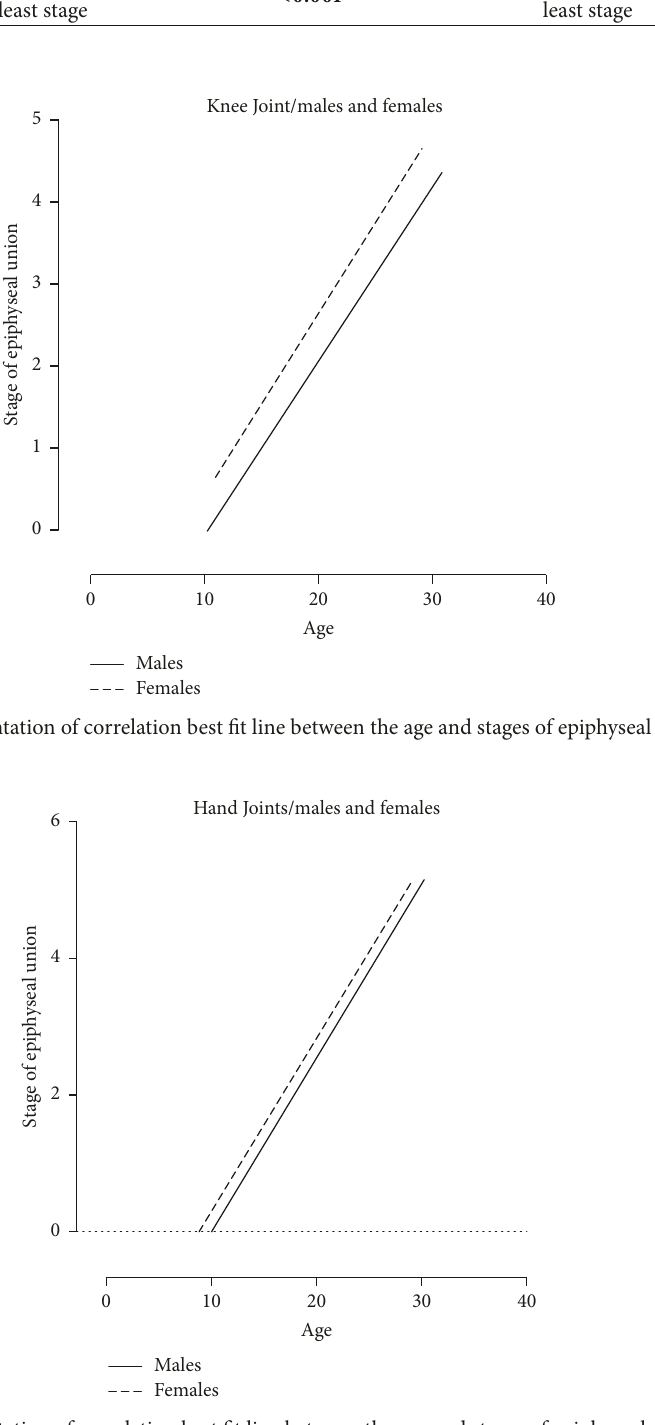
Figure 8: The graphical presentation of correlation best fit line between the age and stages of epiphyseal union in hand